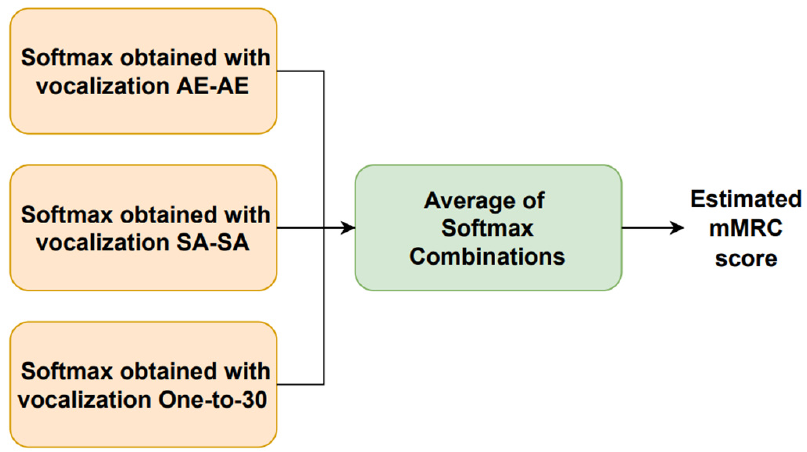
Figure 1. Block diagram of the proposed system.